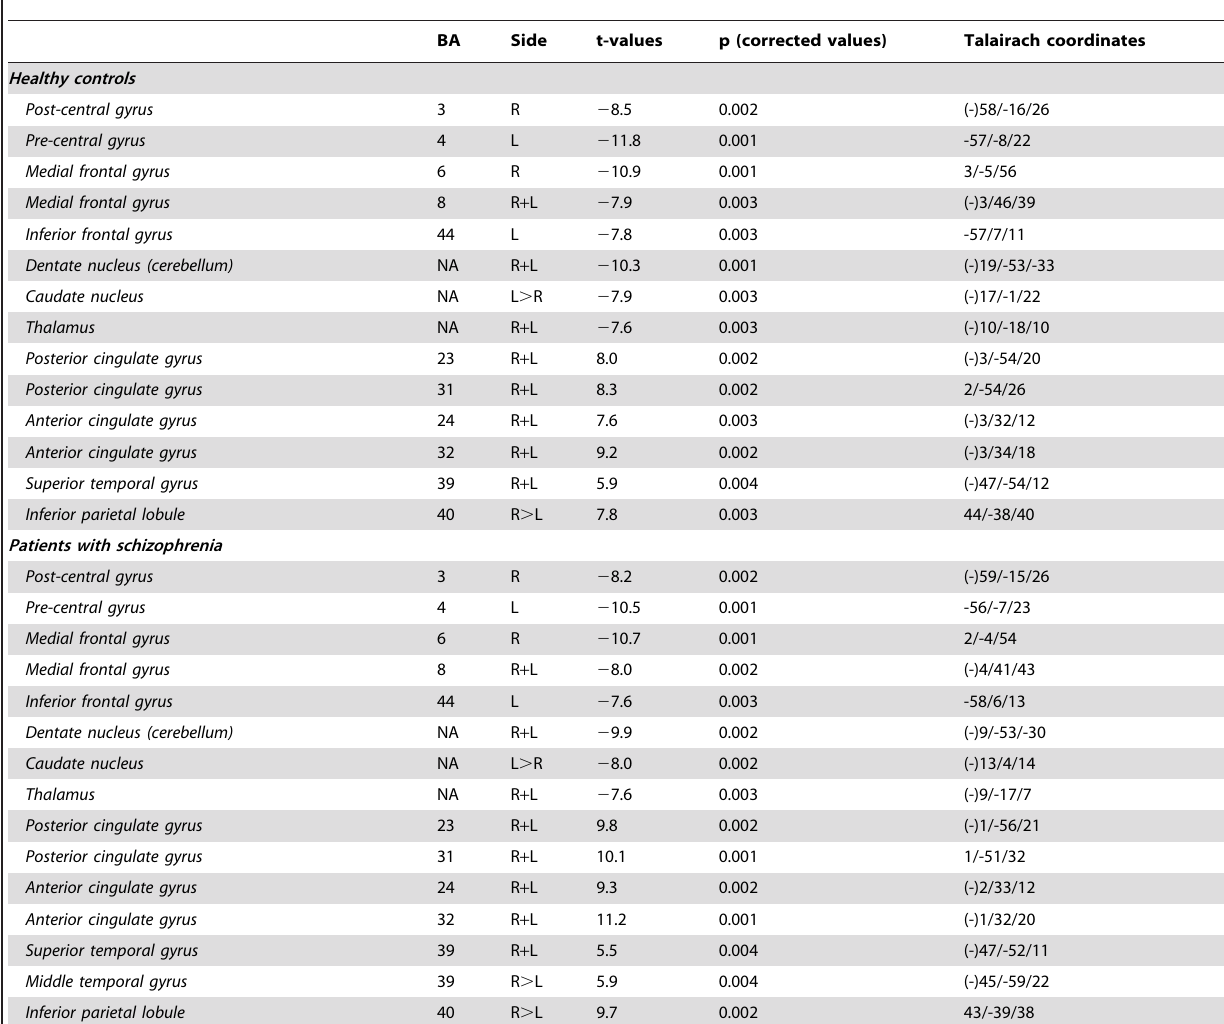
Table 3. Cortical areas involved in implicit self-other distinction in healthy controls and patients with